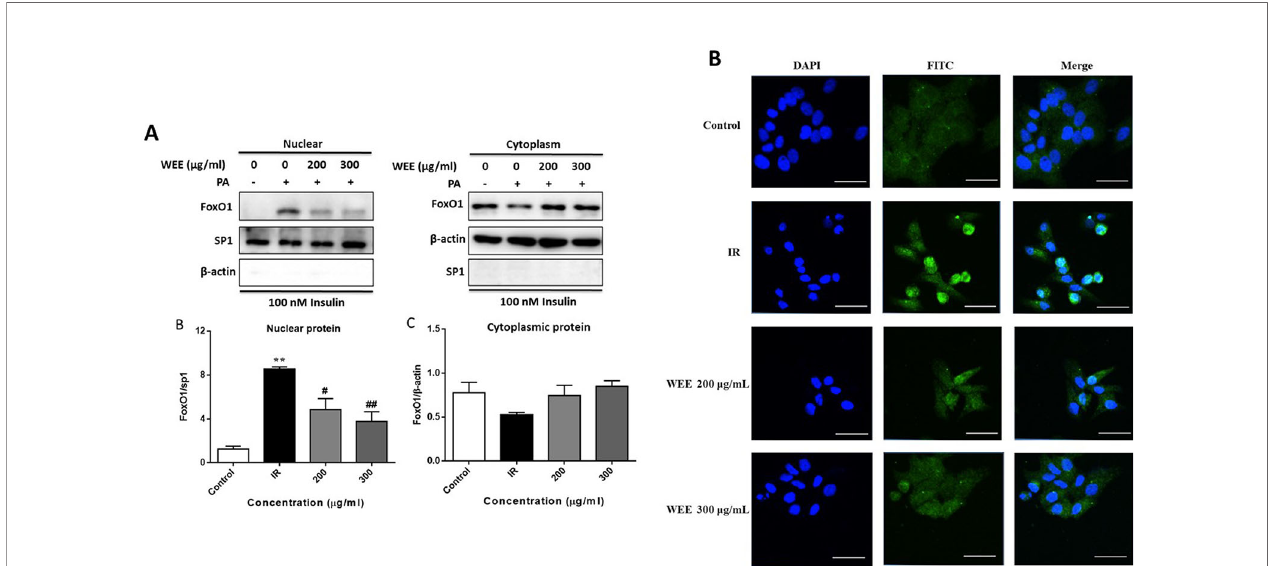
FIGURE 7 | WEE suppressed the nuclear translocation of FoxO1 in PA and high glucose treated HepG2 cells. HepG2 cells were incubated with normal glucose (5.5 mM) or high glucose (30 mM) plus PA (0.3 mM) in the absence or presence of WEE (200 and 300 m g/mL) for 24 h and followed by being stimulated with insulin for 20 min. The cytoplasmic and nuclear protein levels of FoxO1 were determined by Western blotting. Data presented in bar charts are mean ± SEM values from six independent experiments. Groups are signi fi cantly different from the control group at **p < 0.01. The groups are signi fi cantly different from the IR group at # p < 0.05 and ## p < 0.01 determined by Dunnett ’ s multiple comparisons test (A) . The nuclear localization of FoxO1 was determined by immuno fl uorescence staining. The bar in each photograph indicates 33 m m (B)